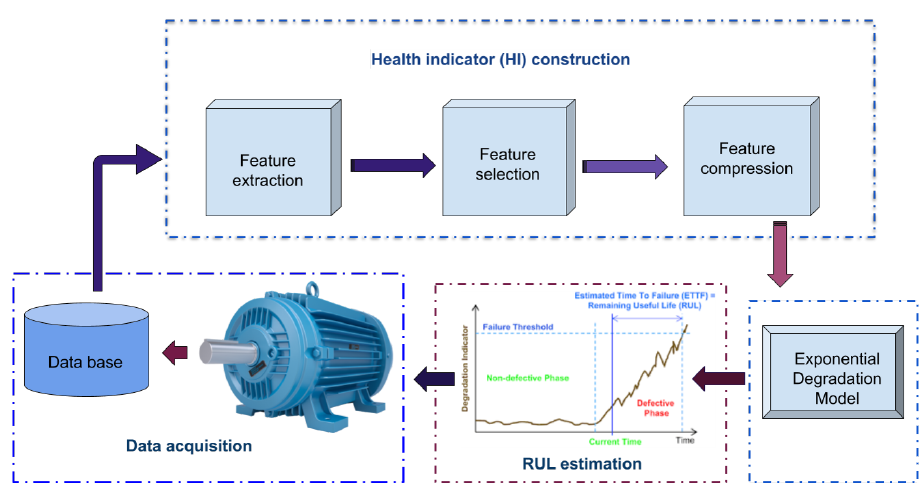
Figure 3. Flowchart of the proposed prognostics